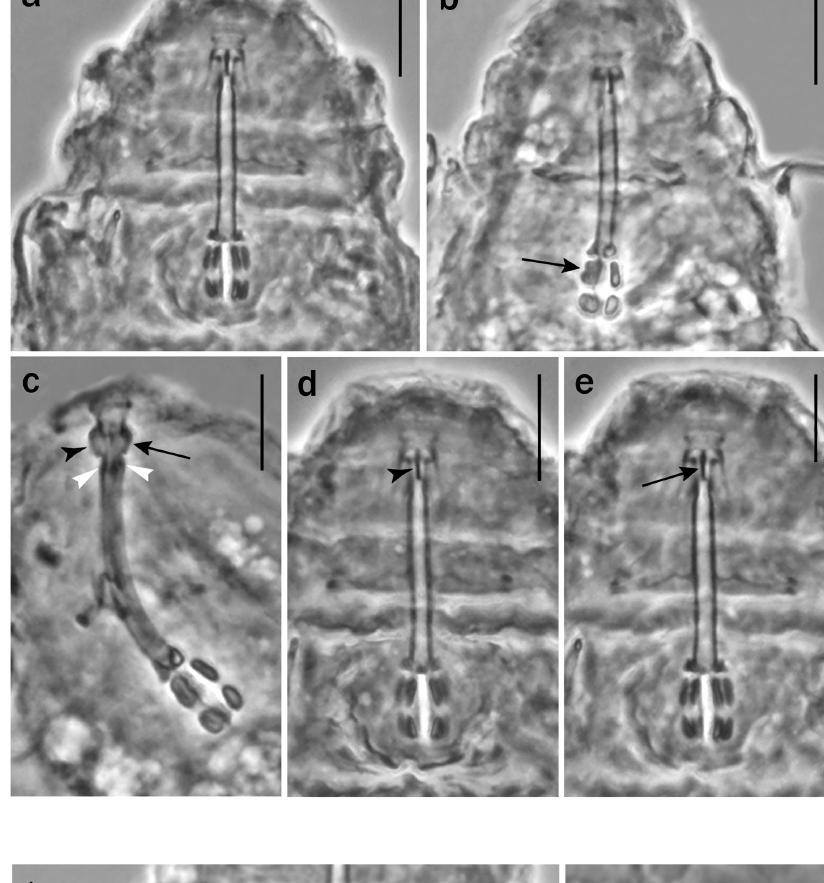
Figure 4. Claws of Mixibius gibbosus sp. nov. (a) claws of legs I and II of the holotype (slide No. 00613-4). (b) claws of legs II of a paratype (slide No. 00512-4); the white arrowhead indicates an accessory point. (c) claws of legs IV of a paratype (slide No. 00515-4). (d) claws of legs IV of another paratype (slide No. 00613-8); the white arrowhead indicates an accessory point; the black arrowheads indicate the pseudolunulae. Scale bars are 10 µm in (a) and (c), and 5 µm in (b) and (d).